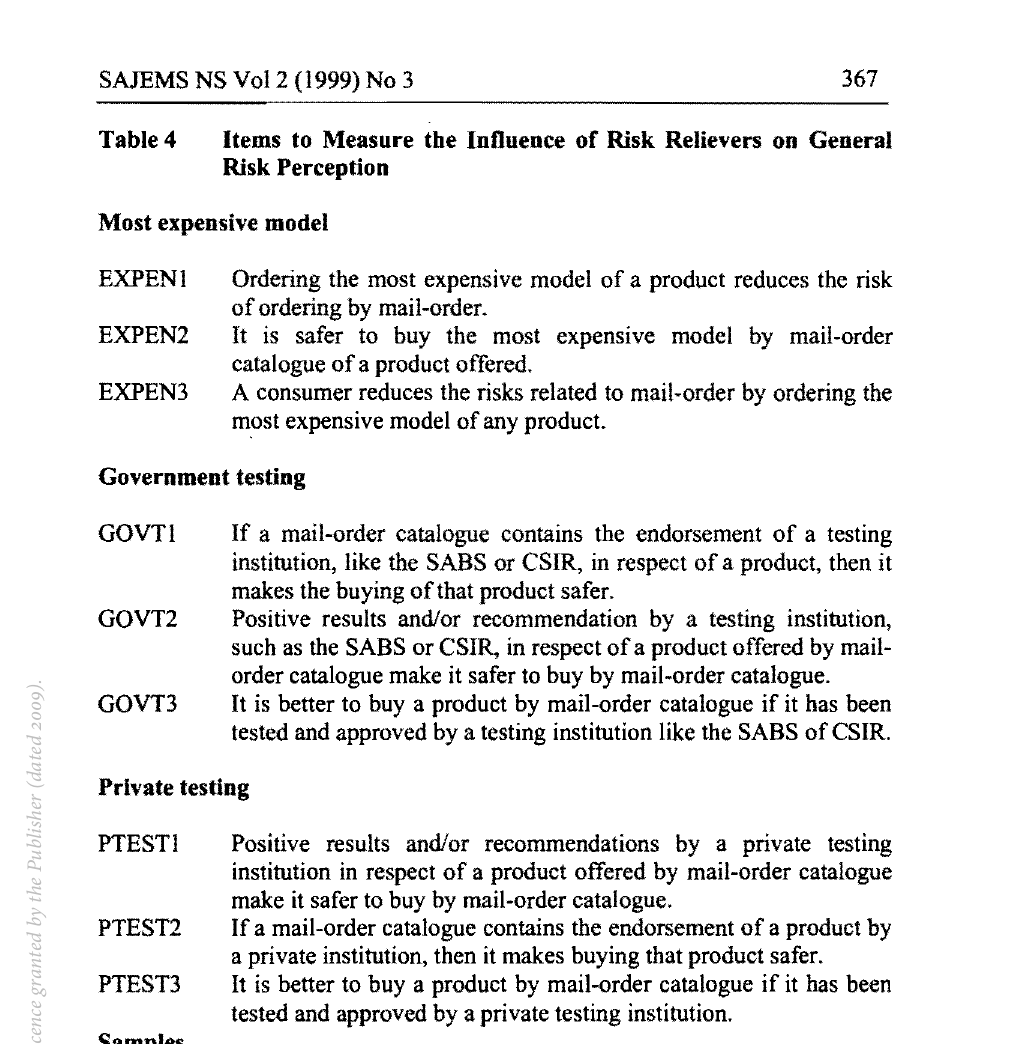
Items to Measure the Influence of Risk Relievers on General Risk